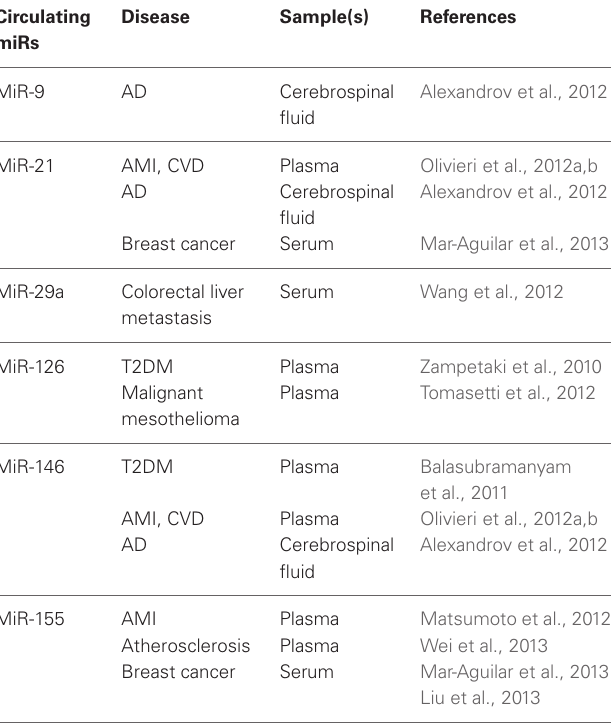
Table 2 | Circulating inflamma-miRs in age-related diseases.